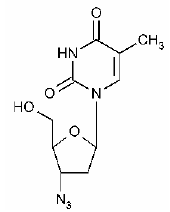
Figure 1 . Chemical structure of zidovudine